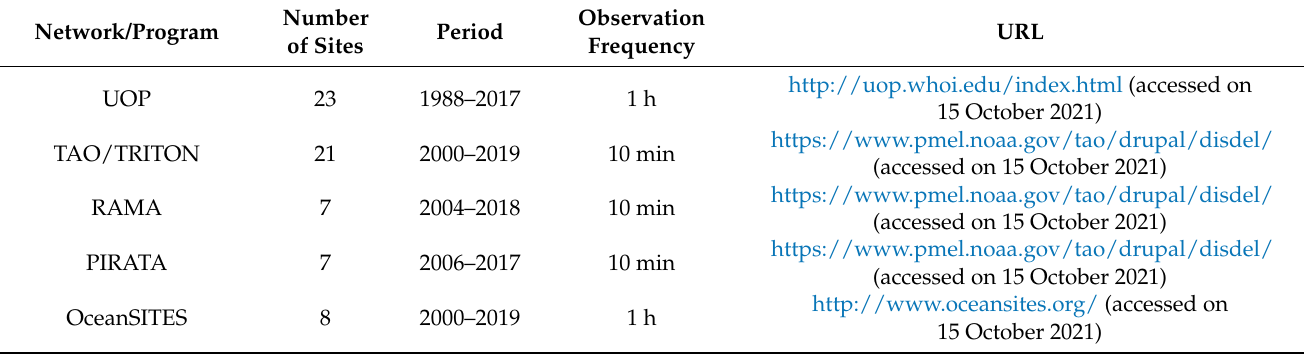
Table 2. Descriptions of each